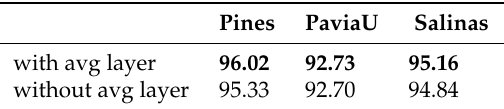
Table 3. Classification performance of the SPPF framework using CNN 2 -lite as the subnetwork with/without the average pooling layer (OA shown in percentage).